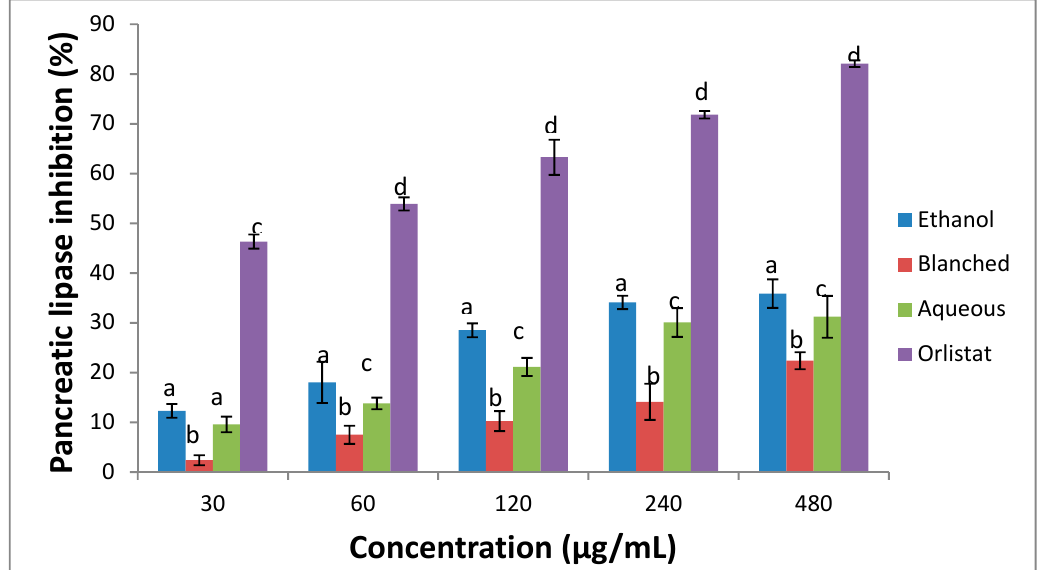
3.5. Glucose Utilization in C3A Hepatocytes Glucose utilization and corresponding cytotoxicity in C3A hepatocytes are pre- sented in Figure 7. All the samples showed weak glucose utilization in C3A hepatocytes compared with metformin treated cells which showed the highest glucose uptake. At 50 µg/mL, only the blanched extract showed a very sharp drop in glucose uptake. Whereas, at the highest concentration tested (100 µg/mL), very weak or no glucose utilization was Figure 6. Pancreatic lipase inhibitory activity of H. arborescens leaf extracts and positive control (orlistat). Values are observed for all the three extracts. The results have also shown that higher concentrations expressed as mean ± SD ( n = 3). Mean separation by SD ( p < 0.05). Set of bars (the same concentration) with different of the extracts drastically reduced the viability of the cells, with the greatest reduction alphabets are different. observed in the blanched extract.